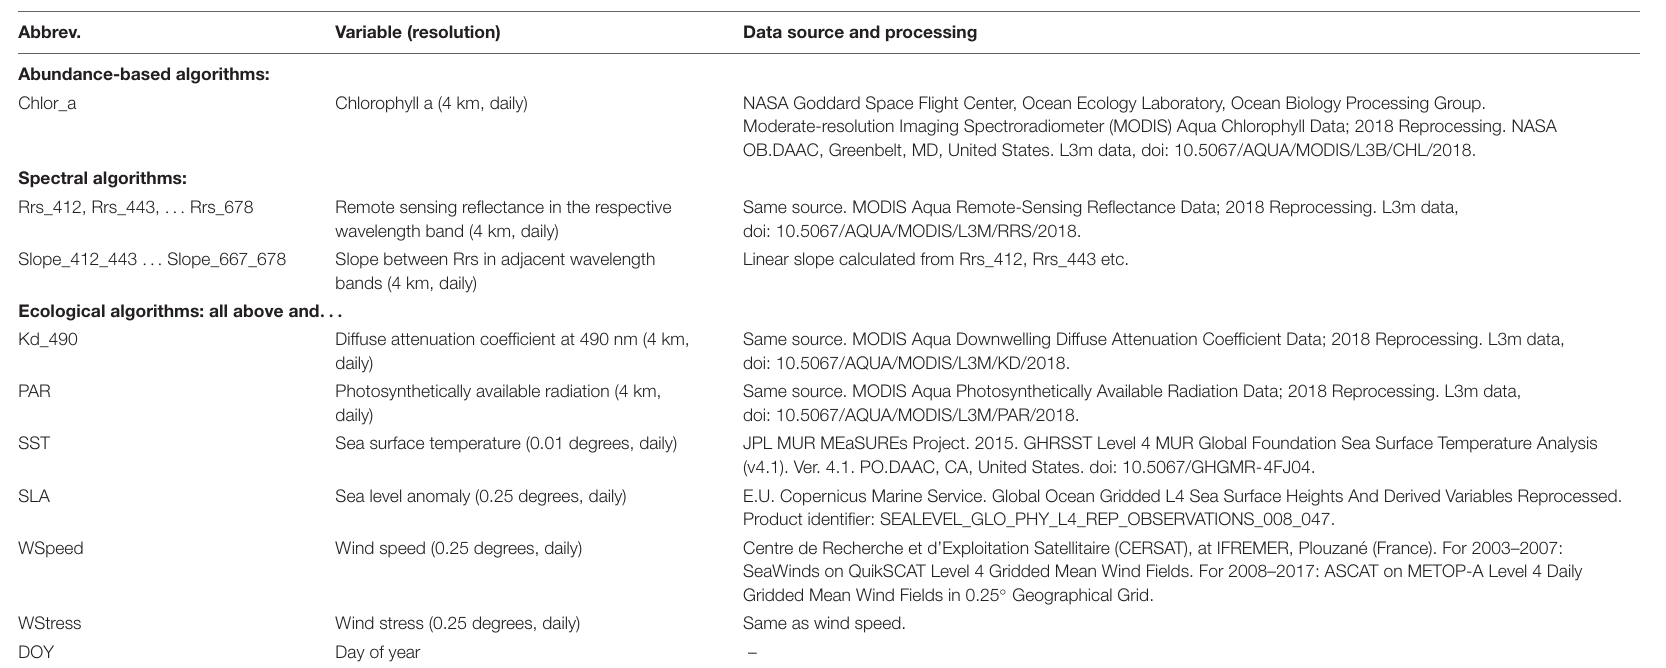
TABLE 1 | Data sources for predictors. Abbrev. Variable (resolution) Data source and